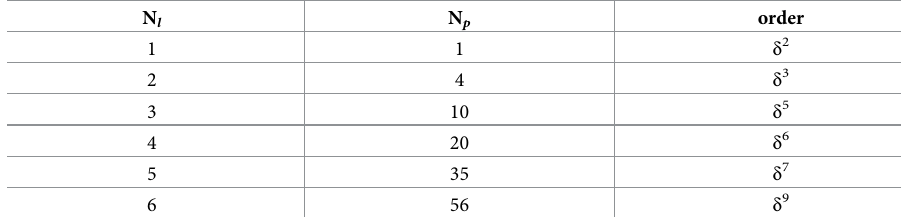
Table 1. Theoretical accuracy of the SQR_CCP integral